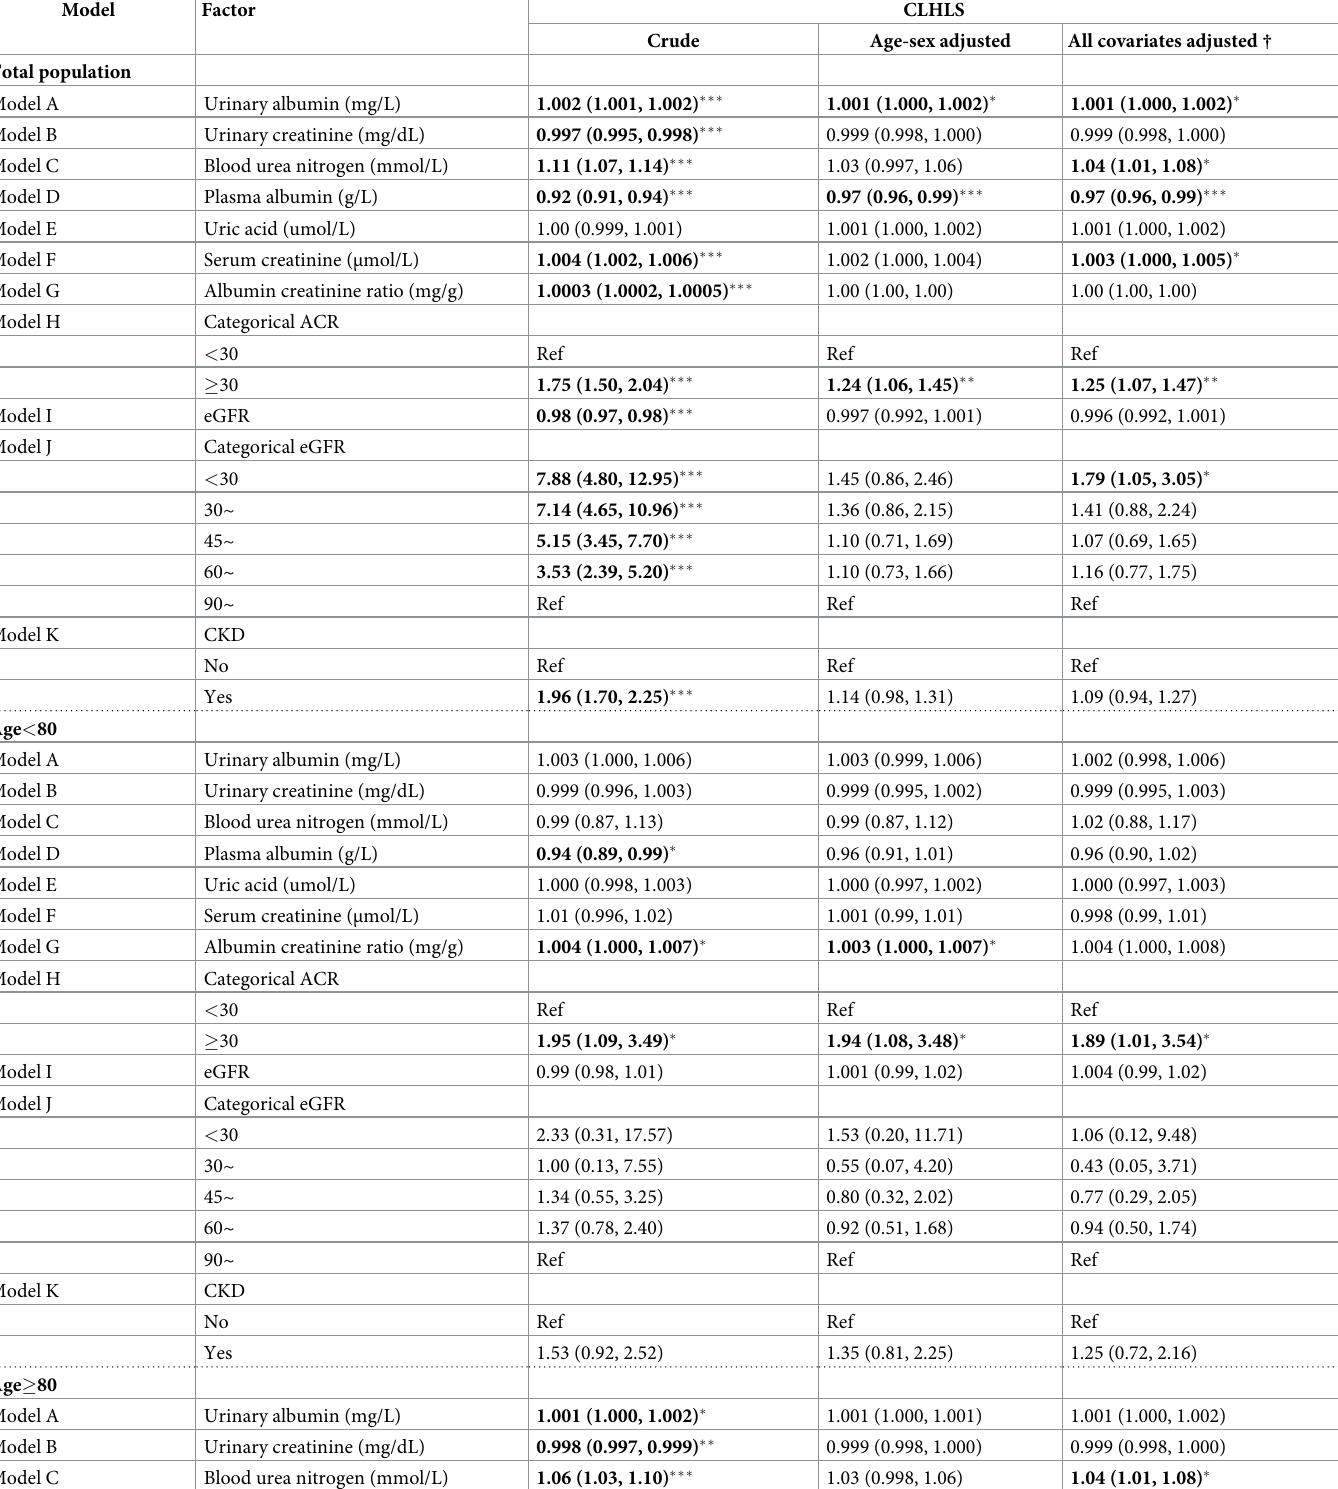
Table 5. Hazard ratio (95% CI) of biomarkers on mortality in Chinese participants (CLHLS 2012).